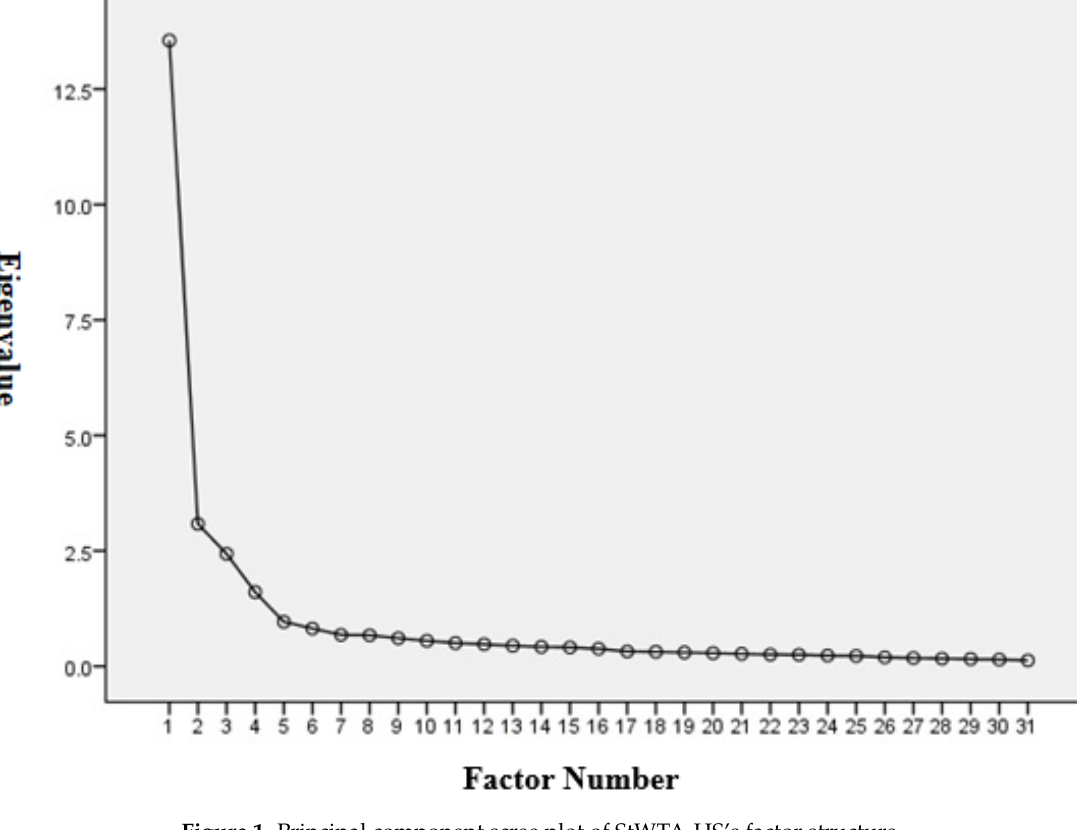
Figure 1. Principal component scree plot of StWTA- HS’s factor structure.